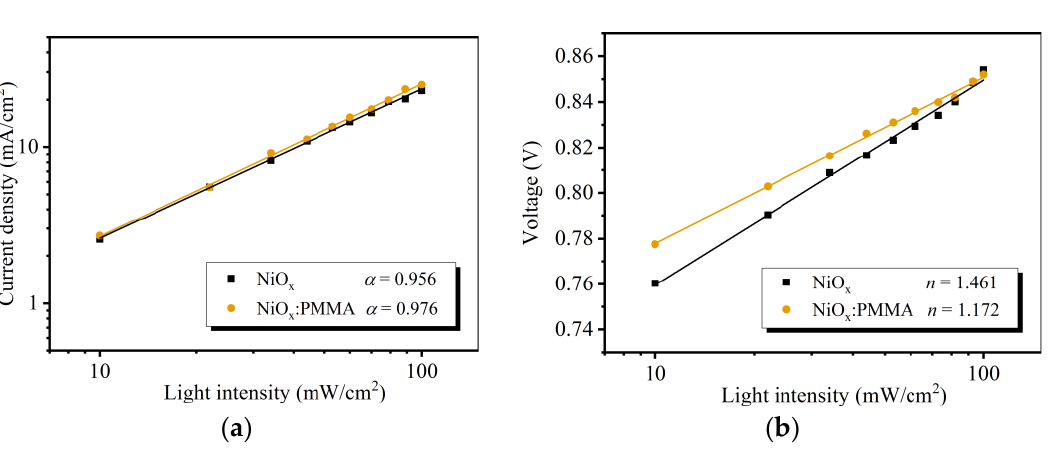
Figure 4. (a) J SC dependence on incident light intensity ( P in ). (b) V OC dependence on P in